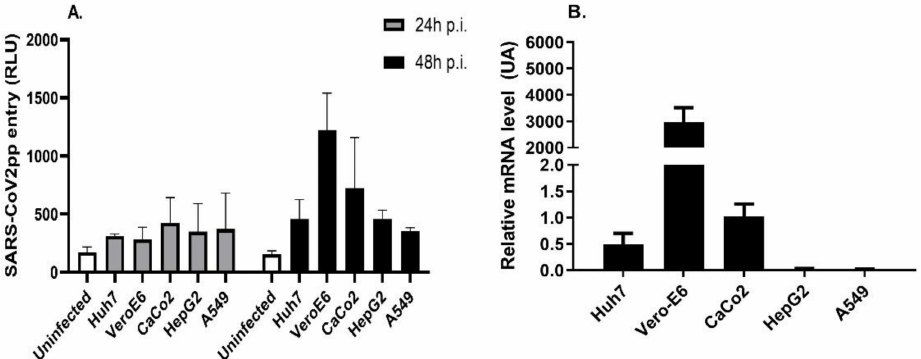
Figure 1. The efficiency of SARS-CoV-2pp entry into cells depends on the level of cellular ACE expression. Different cell lines were infected with SARS-CoV-2pp in complete growth media for 24 h and 48 h. Luciferase activity (expressed in relative light units, RLUs) was measured at 24 h p.i. and 48 h p.i. ( A) . In a separate experiment, cells were used at 48 h p.i. for total RNA extraction to measure mRNA expression levels of the ACE2 receptor by qRT-PCR ( B ). Values are plotted as the mean ± SD. Subsequently, Vero E6 (high- ACE2 -expressing cells) and Huh7 (low- ACE2 -expressing cells) cells were infected with increasing doses of SARS-CoV-2pp for 48 h. The entry of